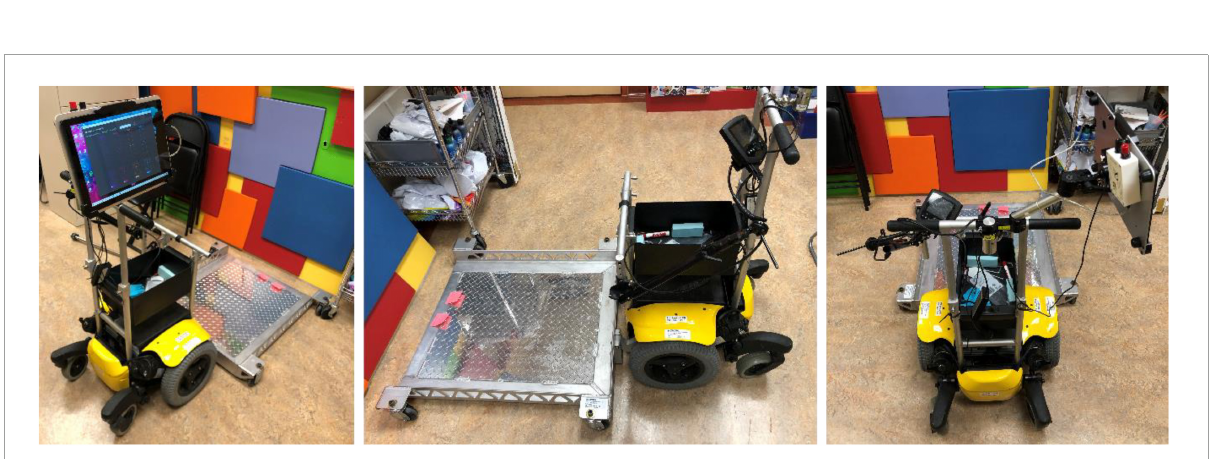
FIGURE4 The power mobility trainer device (PMTD), in three different views. The PMTD consists of a power wheelchair base, attached to and propelling a wheeled platform. Participants sit on this platform in their manual wheelchair and can practice using a new access